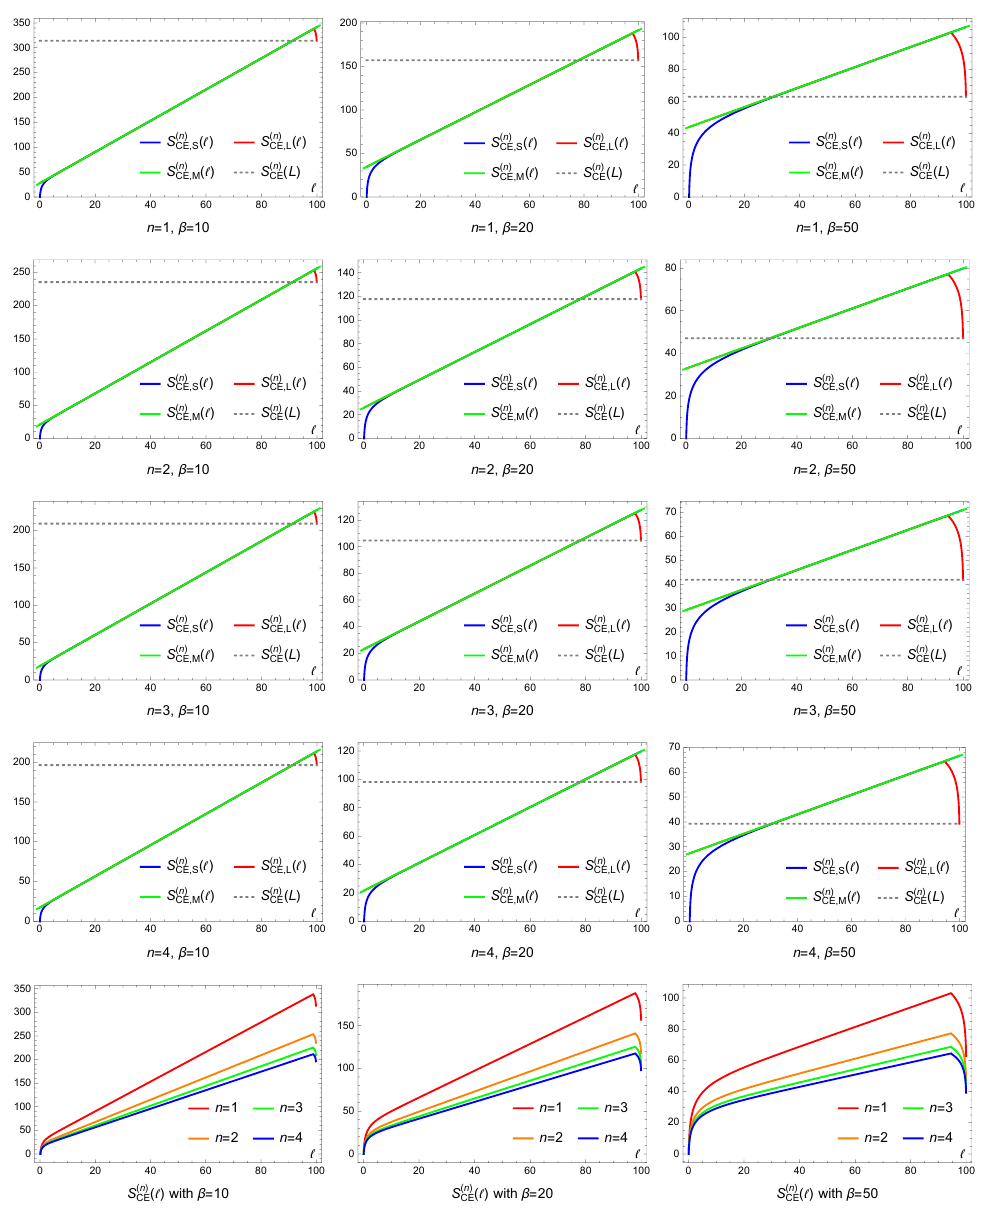
Figure 1 . In the (cid:12)rst four rows, we plot the R(cid:19)enyi entropy of short interval (2.1), medium inter- val (2.5), long interval (2.2) for canonical ensemble state, and we also plot the R(cid:19)enyi entropy of the total system (2.4). In the last row, we plot the piecewise R(cid:19)enyi entropy (2.10). To draw the (cid:12)gures, we have set the central charge c = 30, the length of the entire system L = 100, and UV cuto(cid:11) of the CFT (cid:15) = 0 : 1.